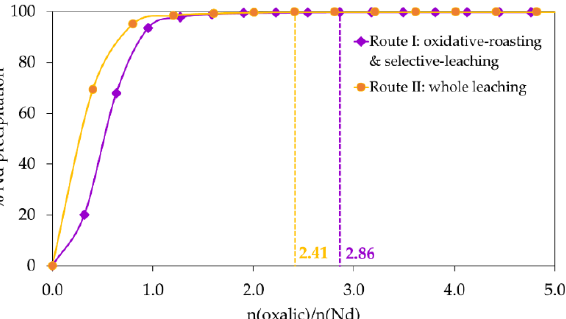
Figure 10. The dependence of Nd precipitation on n(oxalic)/n(Nd), route I: oxidative roasting and selective-leaching, and route II: whole leaching for sintered NdFeB waste.